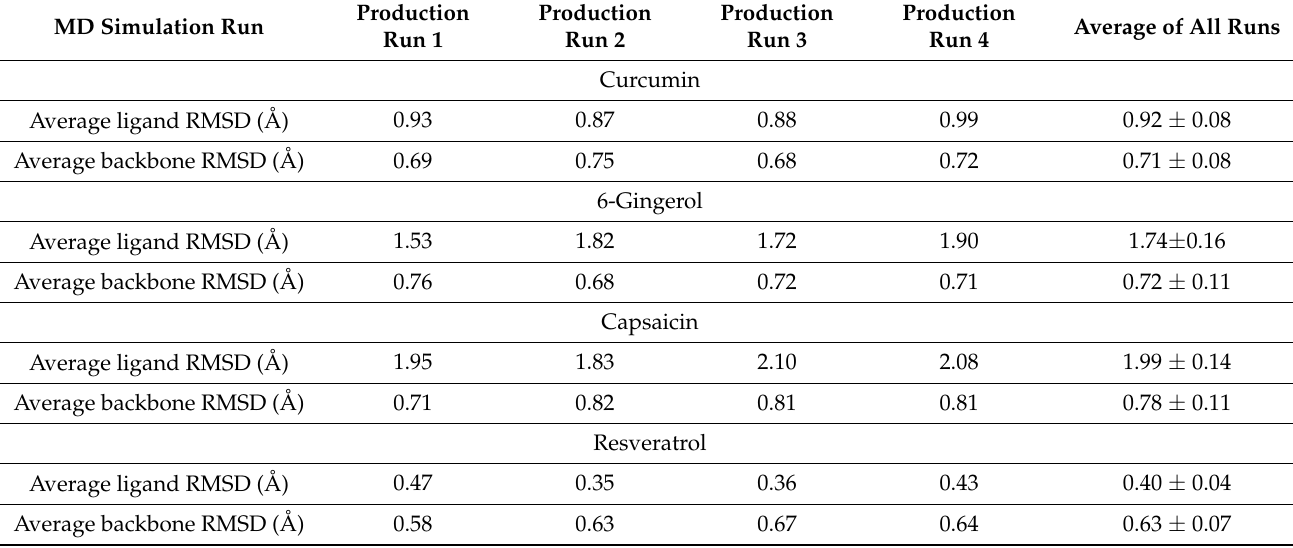
Table 3. Average RMSD values of ligand and protein backbone atomic positions throughout four independent 10 ns molecular dynamics simulation production runs of the four investigated systems: curcumin in complex with PDE4D, 6-gingerol in complex with PDE4D, capsaicin in complex with PDE4D, and resveratrol in complex with